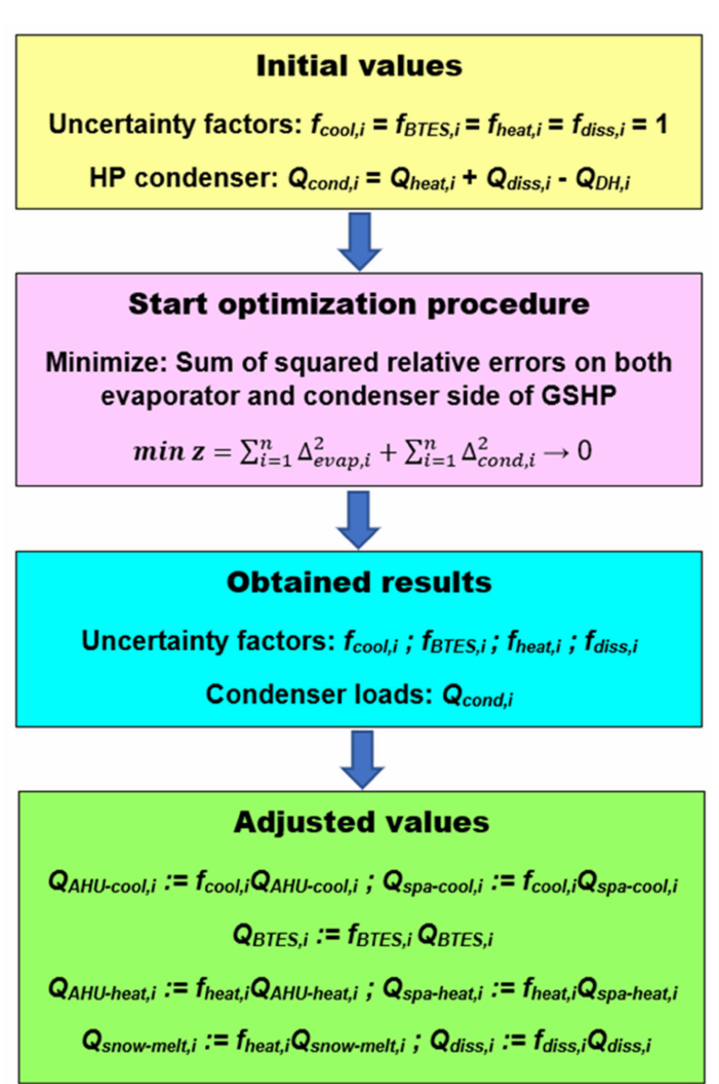
Figure 4. Procedure for data